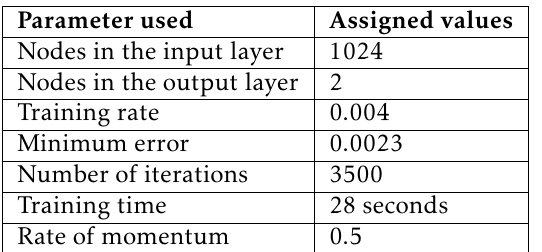
Table 1. Proposed SIFT+BoW method-implementation parame-